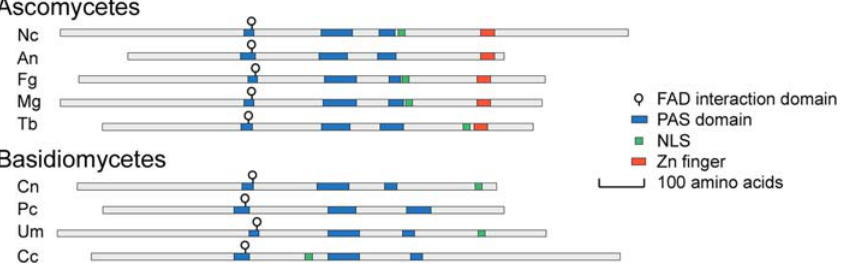
Figure 4. Ascomycete White Collar 1 Homologs Contain a Zinc Finger Domain; The Basidiomycete Homologs Do Not Comparison of the structure of the predicted WC-1 proteins from the ascomycetes N. crassa (Nc), Aspergillus nidulans (An), Magnaporthe grisea (Mg), Fusarium graminarium (Fg), and Tubor borchii (Tb), and the basidiomycetes C. neoformans (Cn), Coprinus cinereus (Cc), Ustilago maydis (Um), and Phanerochaete chrysosporium (Pc). Other domains are PAS ( PER , ARNT , SIM ) and NLS (nuclear localization signal), and the specialized PAS domain that interacts with the chromophore FAD is marked. Sequences are from GenBank (Nc, X94300; An, AF515628; Tb, AJ575416), the Broad Institute (Mg, Cn, Fg, Cc, Um), or the Department of Energy (Pc). DOI: 10.1371/journal.pbio.0030095.g004